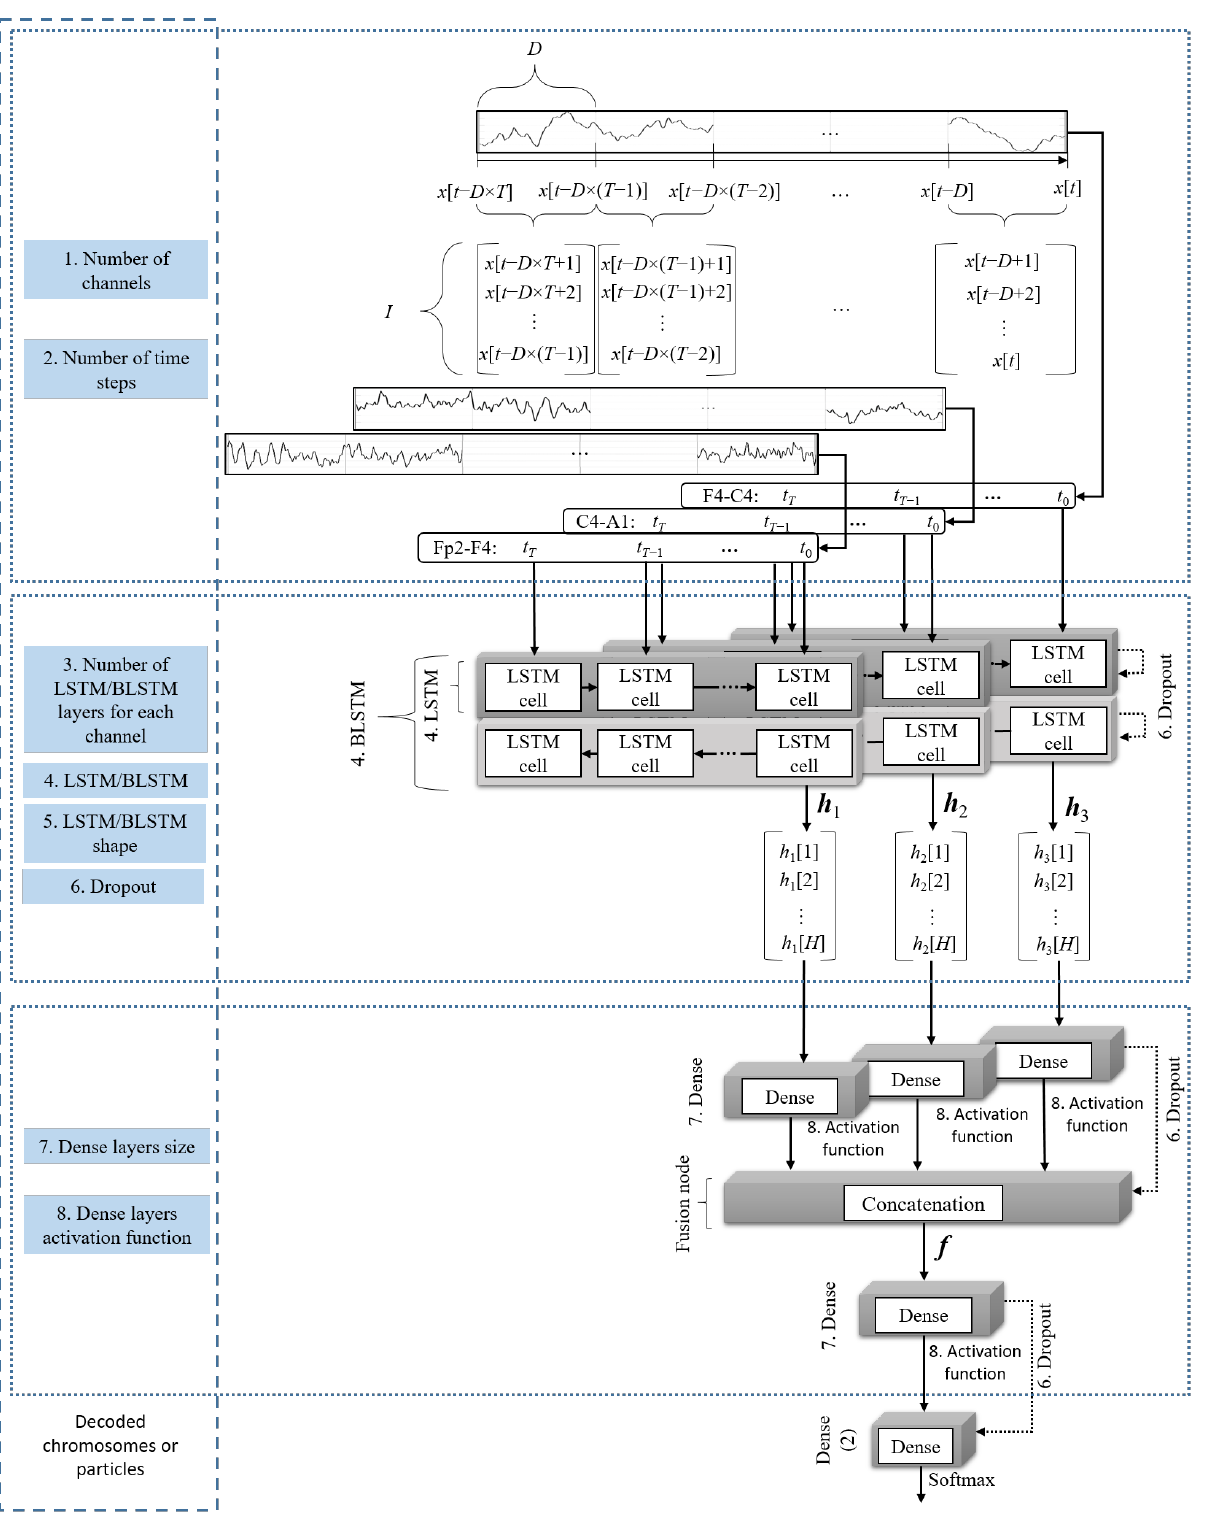
Figure 1. Overview of the implemented model fusing the signal of three EEG channels, using a dense layer to transform the LSTM and concatenation layers outputs.